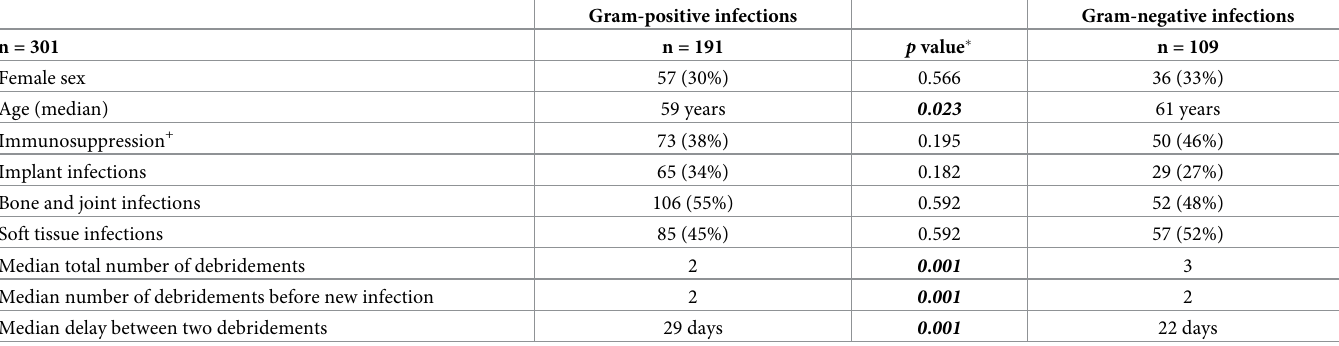
Table 3. Comparison between new Gram-positive and new Gram-negative surgical site infection under ongoing antibiotic therapy (Some episodes have mixed new Gram-positive and Gram-negative infections, which we display in both columns). Gram-positive